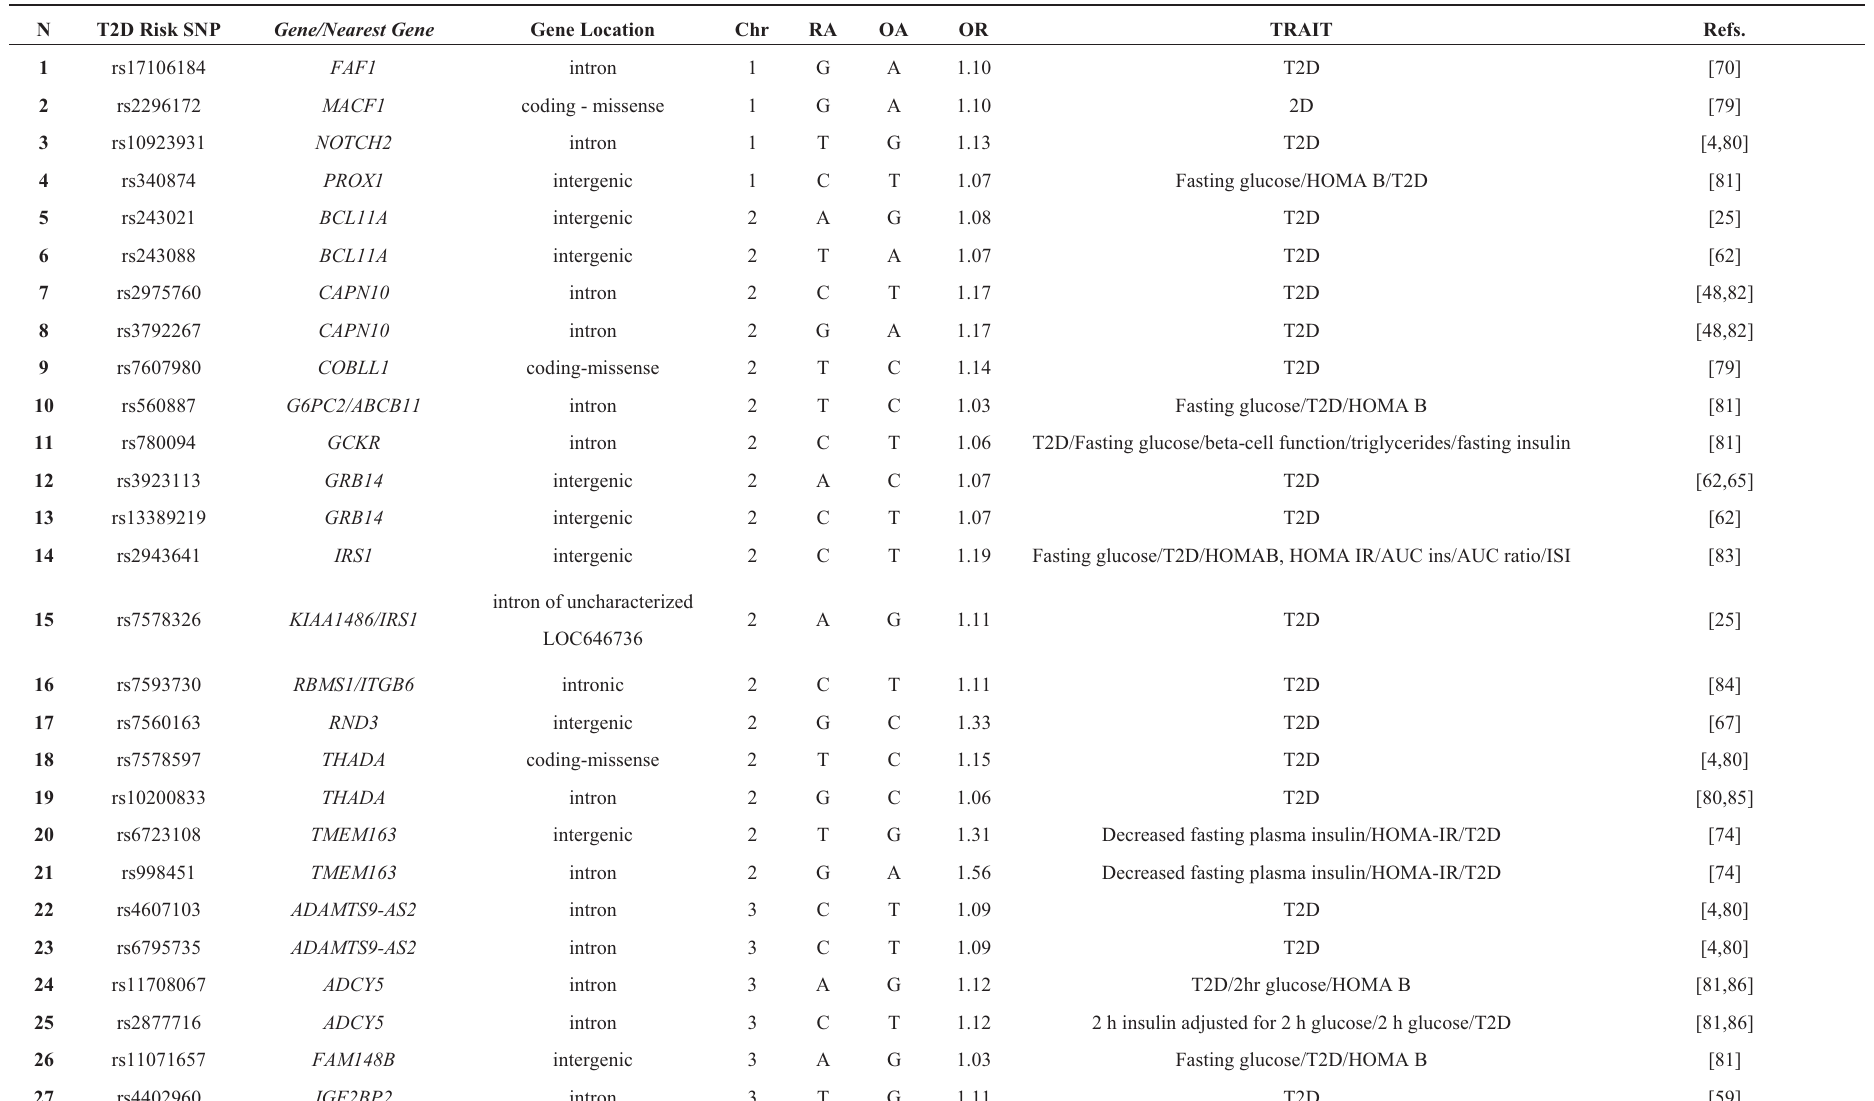
Table 1. Genetic loci associated with risk of